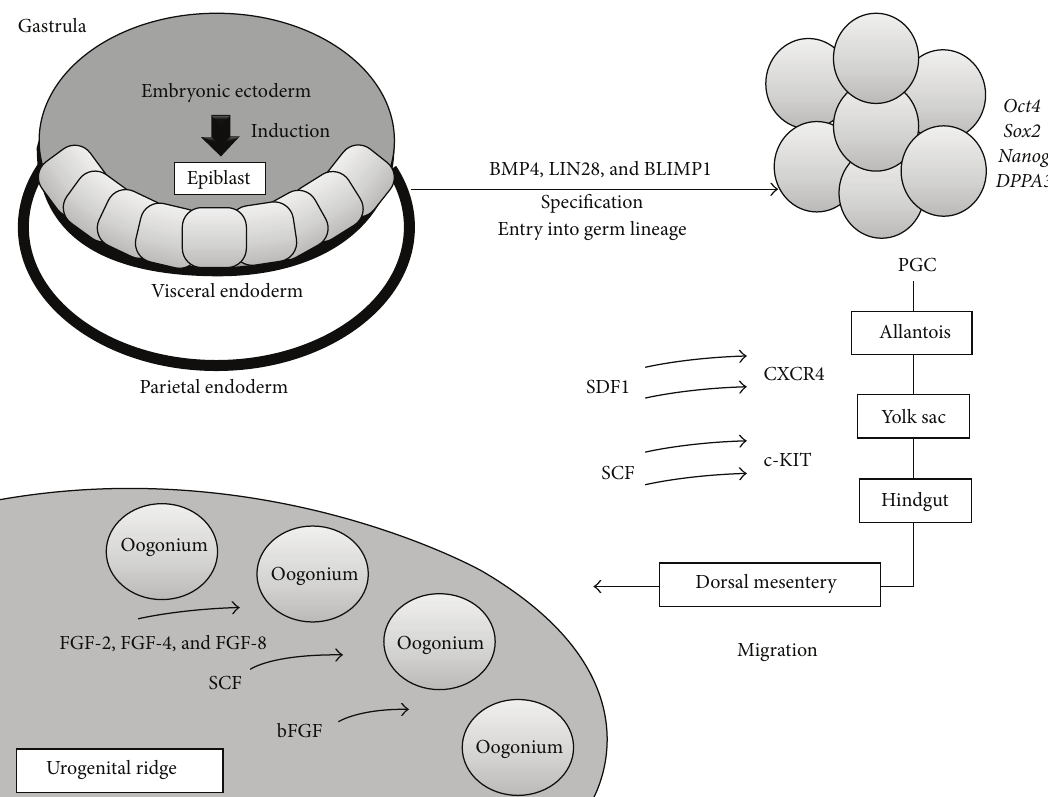
Figure 4: Factors controlling specification and migration of primordial germ cells. bFGF: basic fibroblast growth factor; FGF: fibroblast growth factor; PGC: primordial germ cells; SCF: Stem Cell Factor; SDF1: stromal cell-derived factor. Formation of fully competent gonads demands the presence of PGC in the genital primordia, which in turn requires the fulfillment of two fundamental processes. (1) Specification : PGC stem from a small group of cells which are subjected to induction by the extraembryonic ectoderm, via intense BMP4 signaling, which induces expression of BLIMP1 in these cells. The main factors controlling specification are the expression of pluripotent genes, for example, Oct4 , Sox2 , and Nanog , and thorough epigenetic reprogramming. In addition, BLIMP1 and LIN28 allow expression of DPPA3 (Stella), which mediates protection of maternal imprinting in PGC. (2) Migration : PGC initially reside with the epiblast in the gastrula in the posterior end of the primitive streak, which will later become the extraembryonic mesoderm. Then, PGC migrate through the allantois and reside temporarily in the yolk sac. These cells then migrate caudally through the hindgut towards the dorsal mesentery and then the urogenital ridges, their definitive location. The principal factors regulating this process are SDF1 and SCF, which bind to CXCR4 and c-KIT, respectively, mediating chemotaxis and survival of